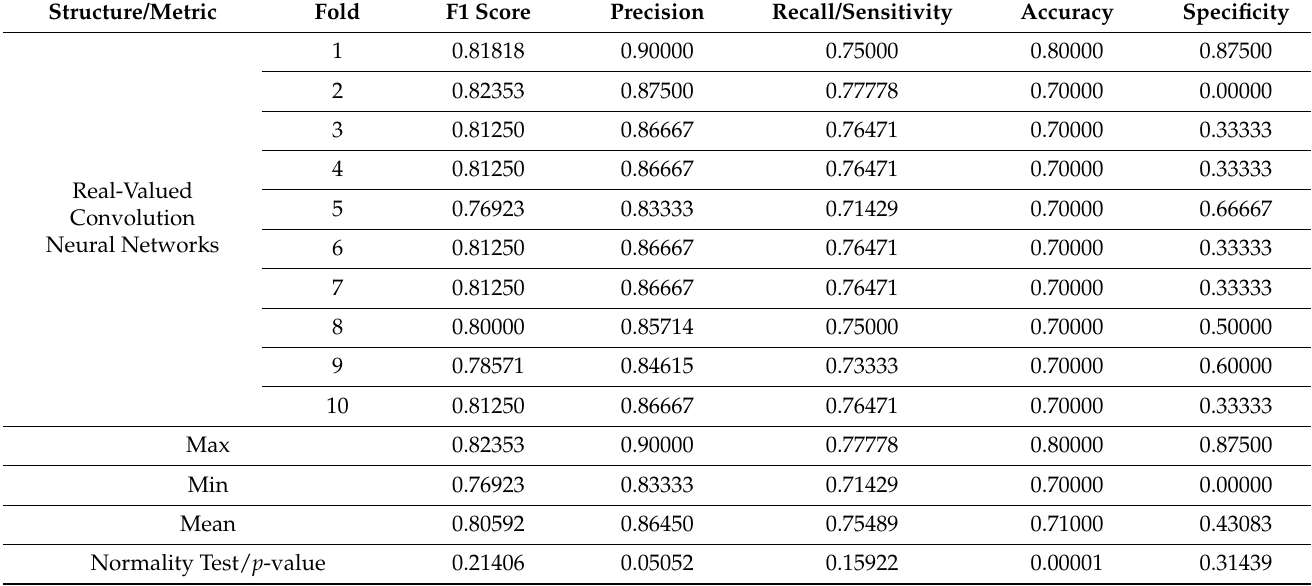
Table 10. Results obtained with the real-valued convolution network studied for the PH2 dataset.